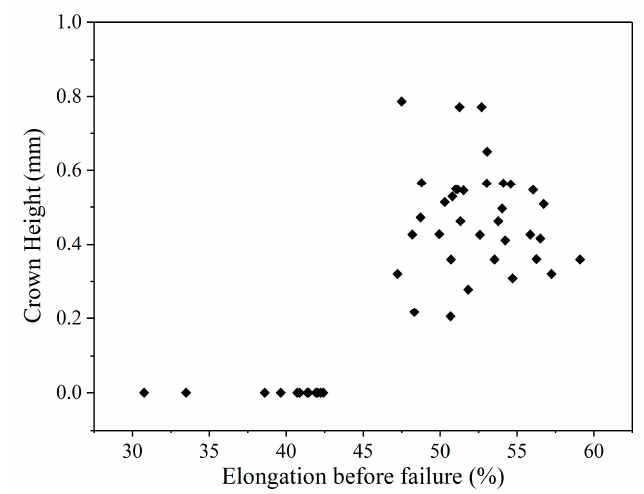
Figure 11. Elongation before failure ( ε ) plotted against the CH. ε is significantly lower when the CH has a zero value.